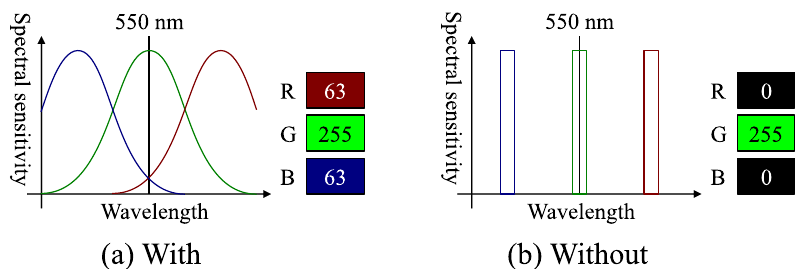
Figure 5. Example of camera spectral sensitivity: ( a ) the sensor that has channel crosstalk; ( b ) the sensor that does not have channel